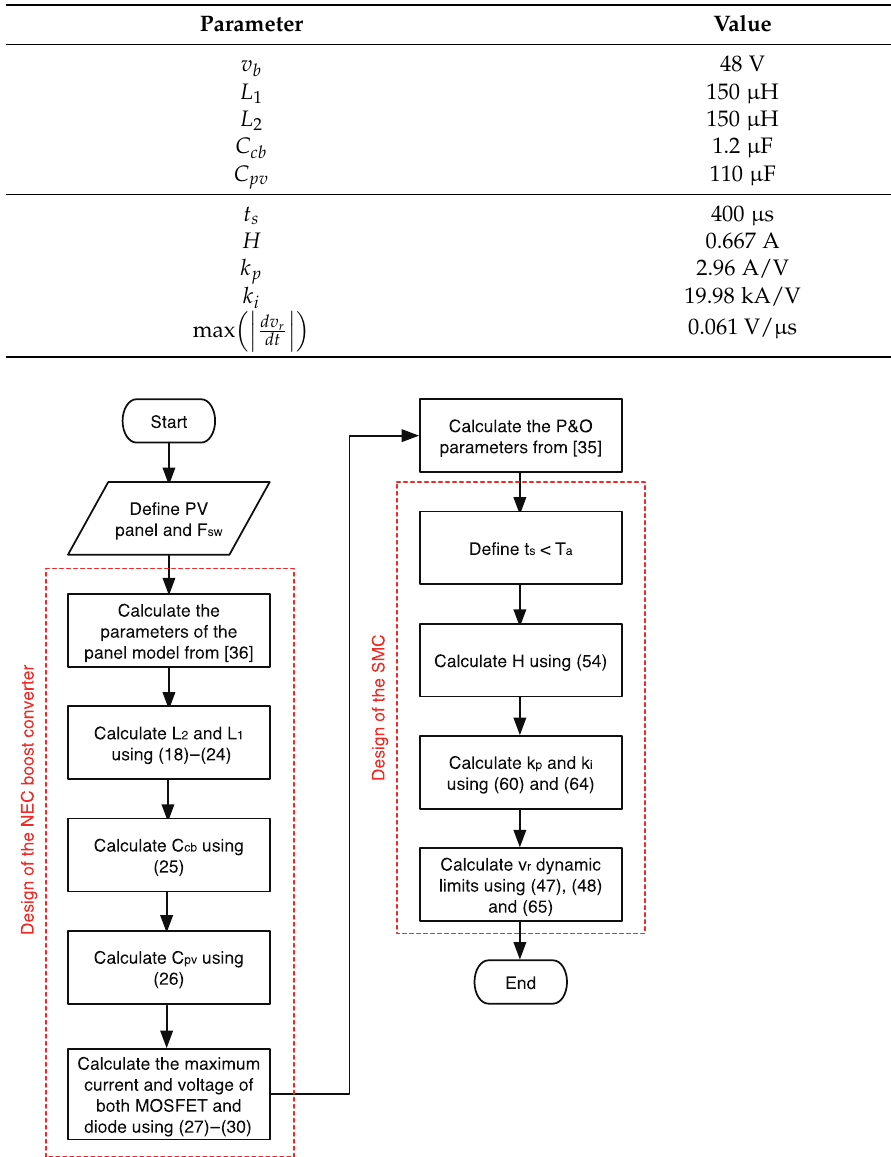
Table 3. Designed parameters for the NEC boost converter and SMC.